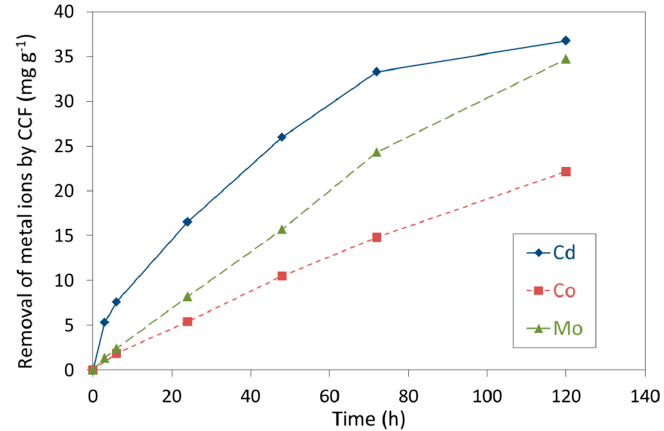
Figure 2. Removal of Cd 2+ , Co 2+ and MoO 42 − ions by CCF.